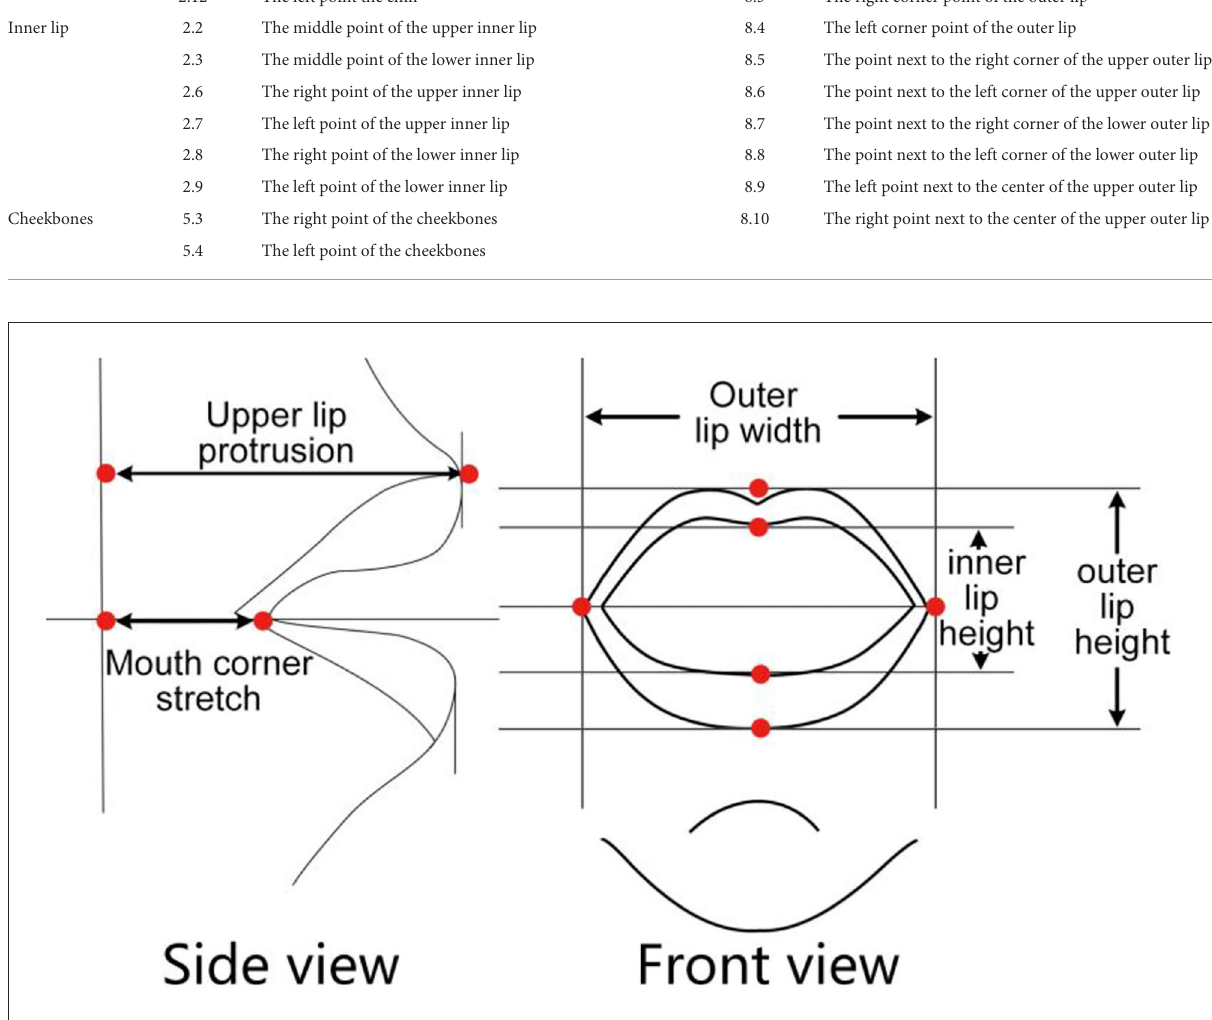
FIGURE3 Parameter